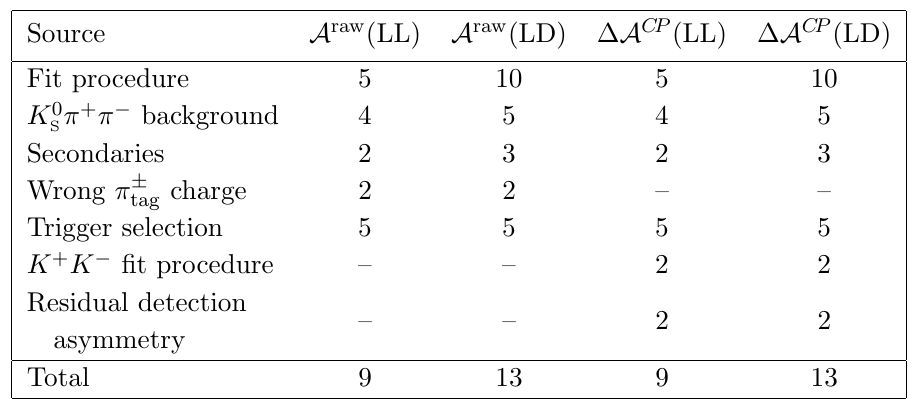
Table 2 . Systematic uncertainties on the quantities A raw and (cid:1) A CP . The total systematic uncer- tainties in the last row are obtained by summing the corresponding contributions in each column in quadrature. Uncertainties are expressed in units of 10 (cid:0) 3